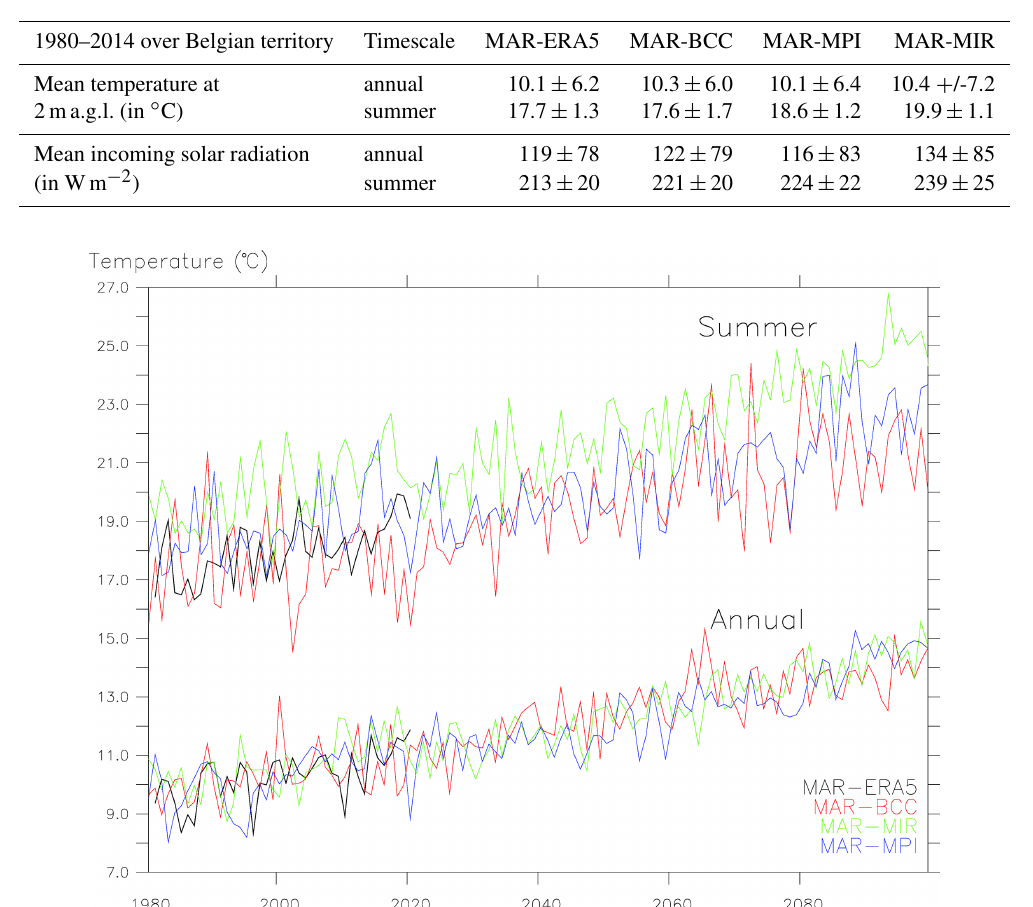
Table 1. Comparison of MAR-ERA5 (i.e. MAR forced by the reanalysis ERA5) with MAR-BCC (i.e. MAR forced by BCC-CSM2-MR),